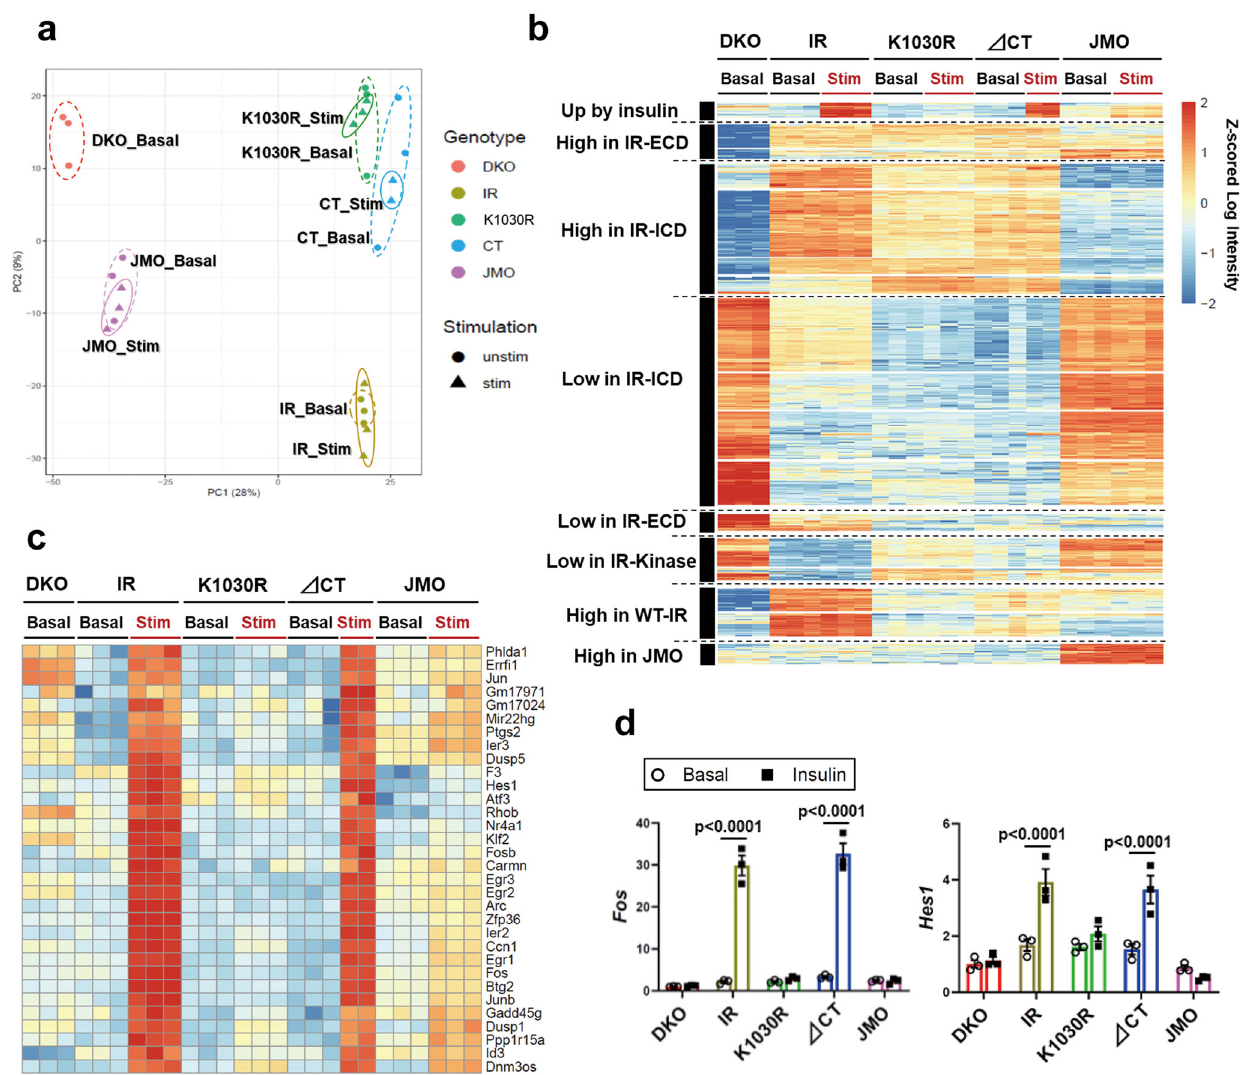
Fig. 4 | Kinase- and domain-dependent roles of IR in gene expressions. a Principal component analysis (PCA) of transcriptomes from DKO, IR, K1030R, Δ CT, and JMO cells. Cells were serum starved for 6h with DMEM containing 0.1% BSA before 100nM insulin stimulation for 15min. b Heatmap showing the hier- archicalclusteringofregulatedgenesinDKO,IR,K1030R, Δ CT,andJMOcellsinthe